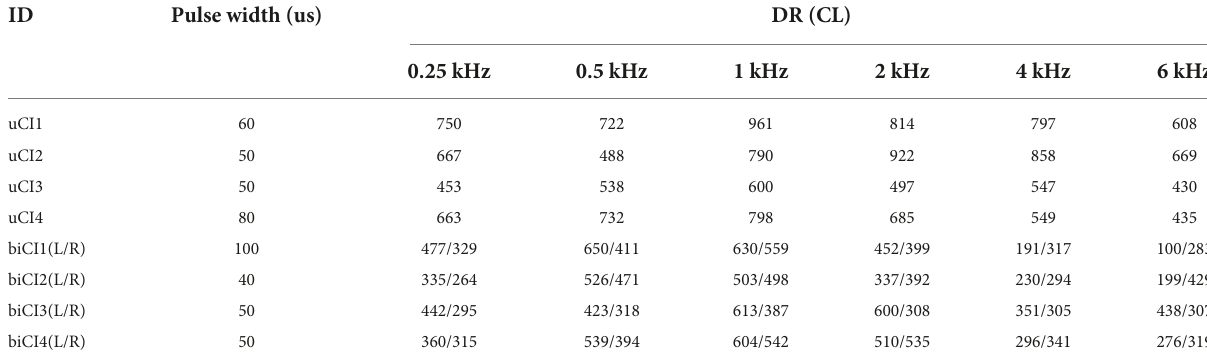
TABLE 2 Used pulse width in µ s and measured dynamic range (DR) in CL for the six used electrodes corresponding to 0.25, 0.5, 1, 2, 4, 6